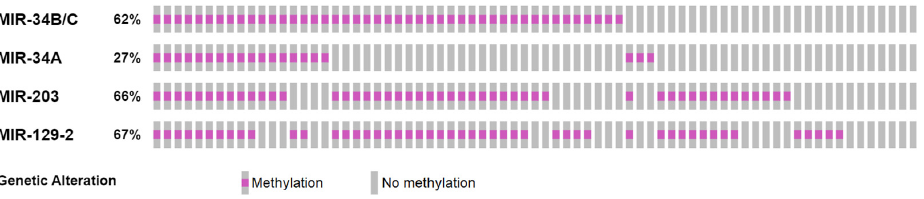
Figure 1. The MIR-203 , MIR-129-2 , MIR-34A and MIR-34B/C genes’ methylation in lymphoma samples. Table 2. The analysis of the tested pairs among the MIR-34A , MIR-34B/C , MIR-203 and MIR-129-2 genes’ methylation by the